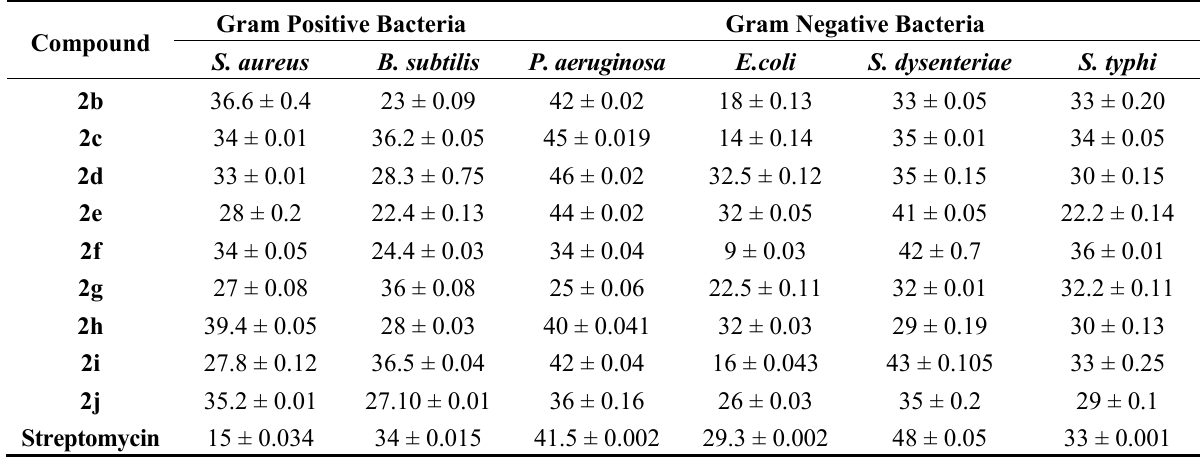
Table 2. Antibacterial activity of synthetic compounds at 25 µg/mL *. Compound